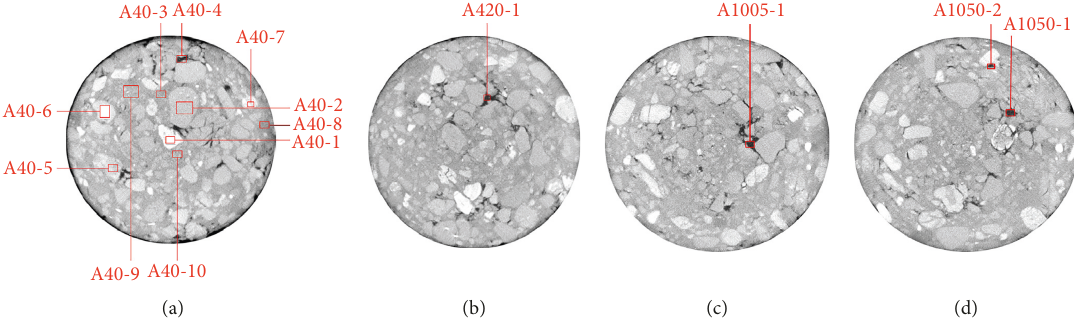
Figure 3: Greyscale value frequency of a local, statistical